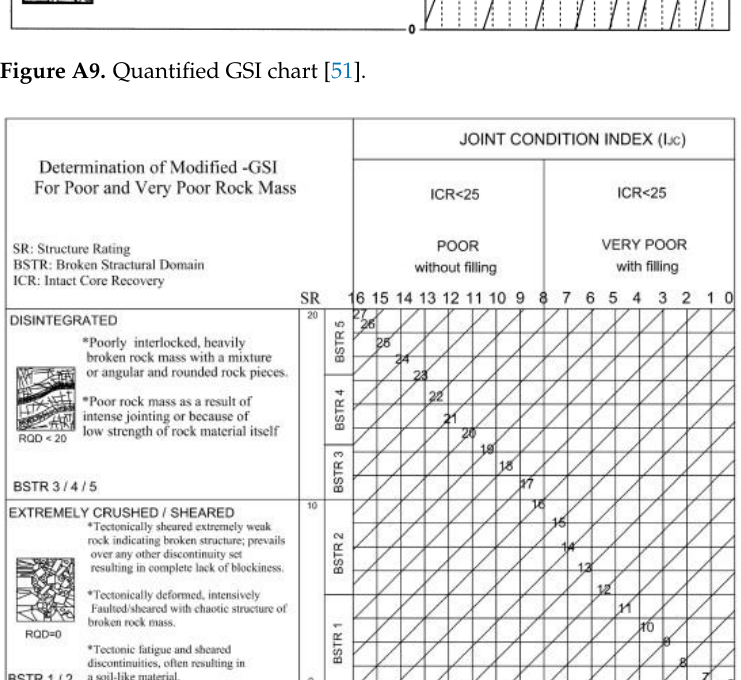
Figure A10. Quantified GSI chart [52].